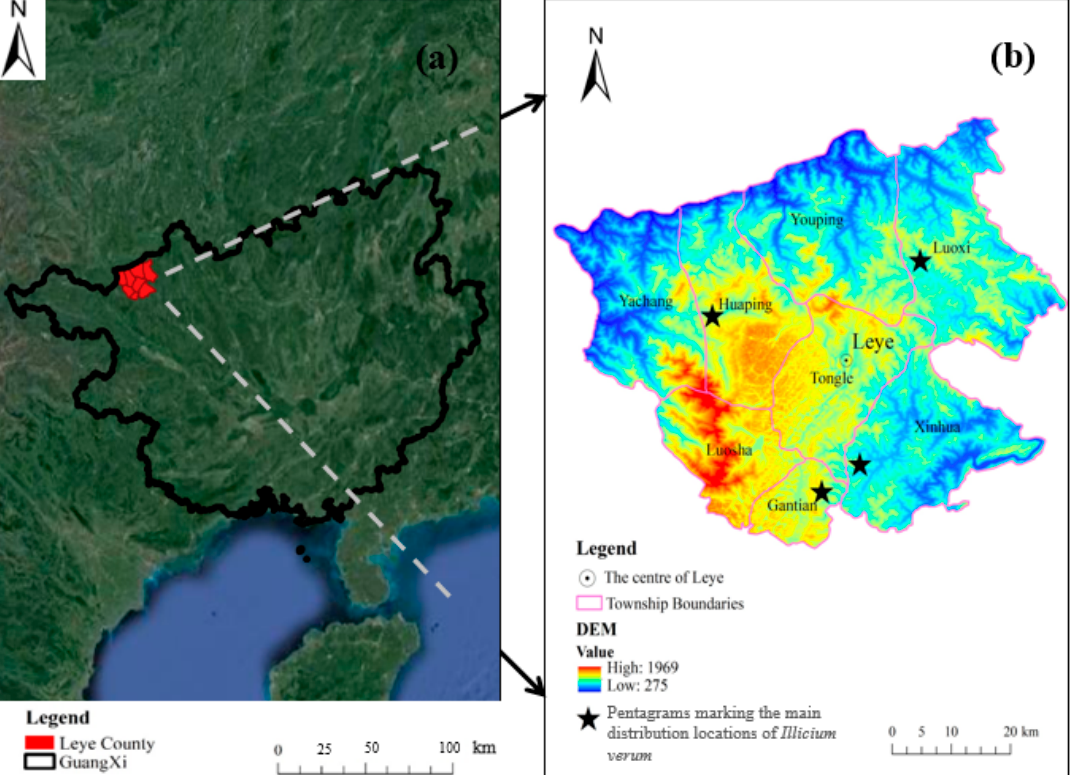
Figure 1. Study area location distribution map: ( a ) Location map of Leye County, Guangxi using Google satellite imagery; ( b ) Digital Elevation Model of Leye County. Pentagrams were used to highlight the four areas in the study area with the largest area covered by Illicium verum , namely Luoxi, Huaping, Gantian, and Xinhua.